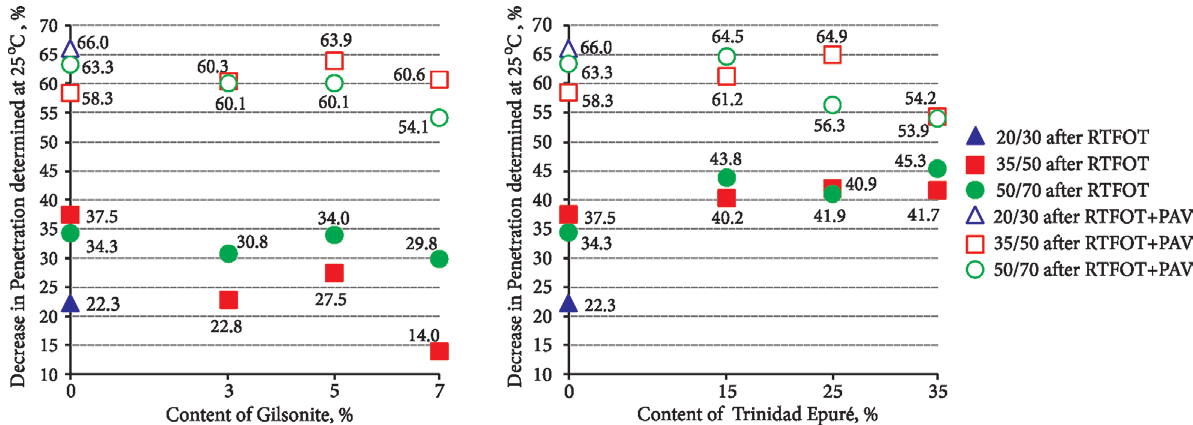
Fig. 1. A decrease in the penetration value at 25 °C of the Gilsonite and Trinidad Epuré modified asphalt binders as a result of aging using the RTFOT method and aging using both the RTFOT and the PAV methods